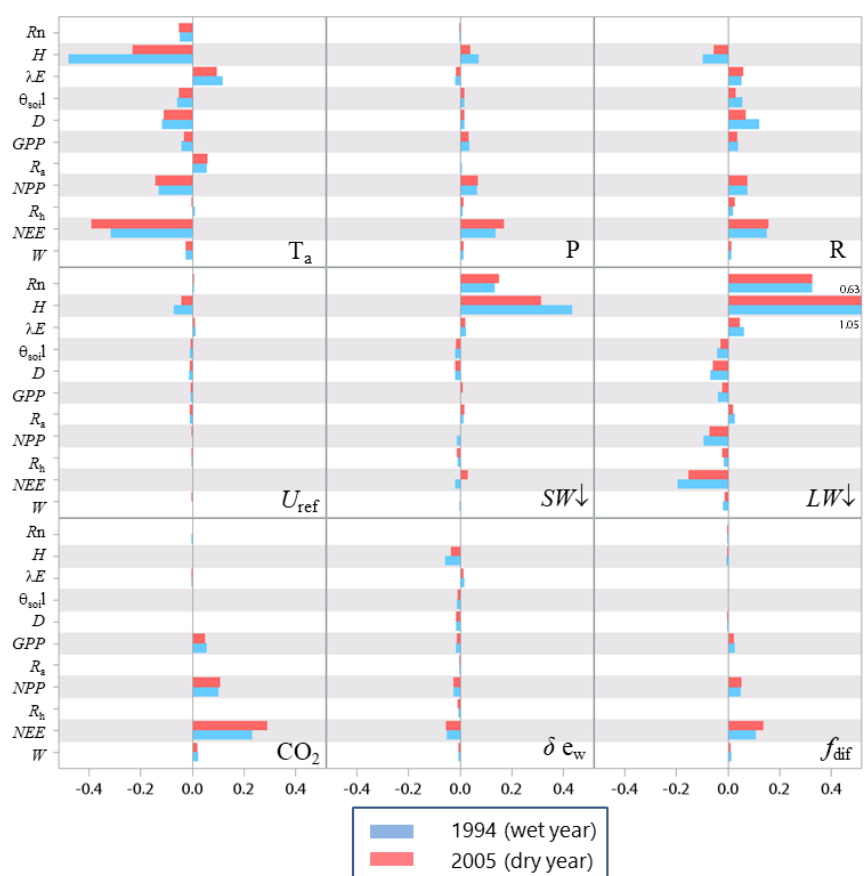
Figure 10. Relative sensitivity of the main variables related to fluxes of energy, water and carbon to meteorological variables for a wet (1994) and dry year (2005) at the Le Bray site. The definition of the variables is provided in Tables 1 and A1.